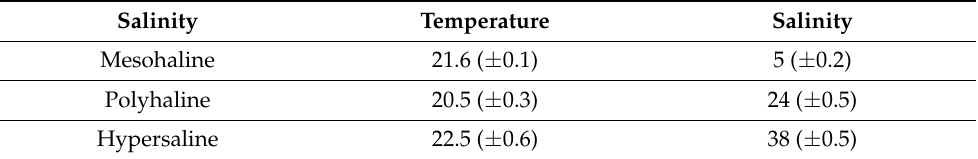
Table 1. Mean water temperature and salinity in the three hydrological phases of the temporarily open/closed Kasouga Estuary located along the southeastern coastline of South Africa. Error bars are standard deviation (n =